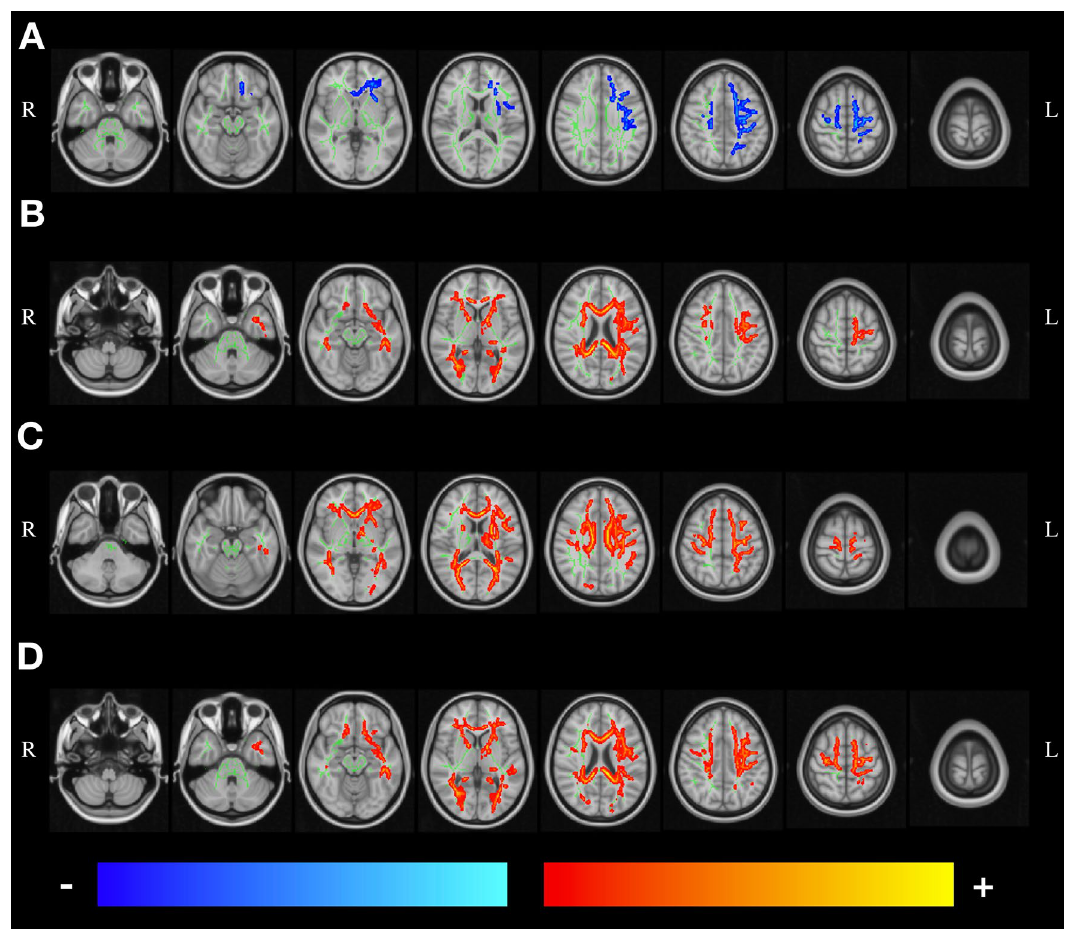
Figure 1. Statistically significant changes along time in ( A ) FA, ( B ) AD, ( C ) RD and ( D ) MD maps. Blue/light- blue gradient indicates decreases along time. Red/yellow gradient indicates increases along time. All results were considered significant at p < 0.05 (FWE corrected for multiple comparisons). We observe a decrease in FA with a left hemisphere dominant pattern, while the other metrics (AD, RD and MD) exhibit an increase between timepoints with the changes being spread throughout the brain.